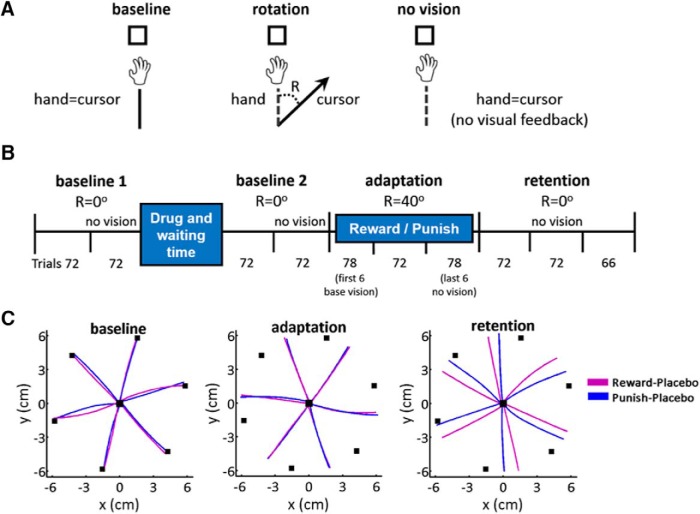

Task and paradigm. A, Task. Participants made 6 cm reaching movements to a target. Visual feedback was perturbed by a 40° clockwise rotation (R) in adaptation phase (rotation). In no vision trials, the cursor and the hand position corresponded but there was no visual feedback. B, Study protocol. Participants completed 72 trials of baseline training with veridical visual feedback, followed by 72 baseline trails with no visual feedback (no vision). Drug (LD/haloperidol/placebo) was then administered and participants waited the corresponding waiting time (1 h for LD or placebo, 2 h for haloperidol). After that, the two baseline blocks were repeated (baseline 2). During adaptation, visual feedback was perturbed 40° clockwise for 216 trials (three blocks). To avoid this starting abruptly at the beginning of a block, the first adaptation block started with six baseline trials with veridical visual feedback, followed by 72 trials with the perturbation. Then, participants were exposed to 216 (retention, three blocks) trials with no perturbation and no visual feedback. Again, to avoid a context change at the beginning of a block, the last adaptation block finished with six retention trials (i.e., total 78 trials in last adaptation block, followed by two retention blocks of 72 trials and one block of 66 trials). C, Hand trajectories toward each target of one representative subject in the R-Pl (violet) and punish-placebo (blue) group. From left to right, Last trial toward each target of baseline 1, last trial toward each target of adaptation, last trial toward each target of retention.